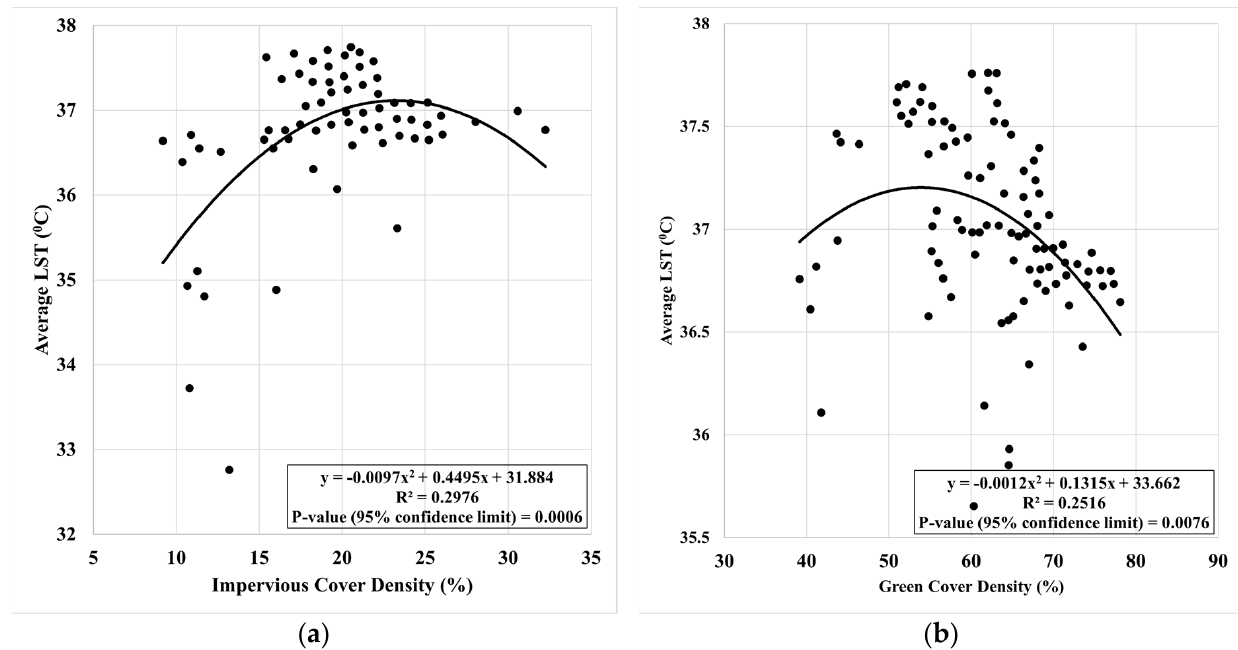
Figure 4. Correlation plots between average LST along urban rural gradient and ( a ) impervious cover density and ( b ) green cover density.